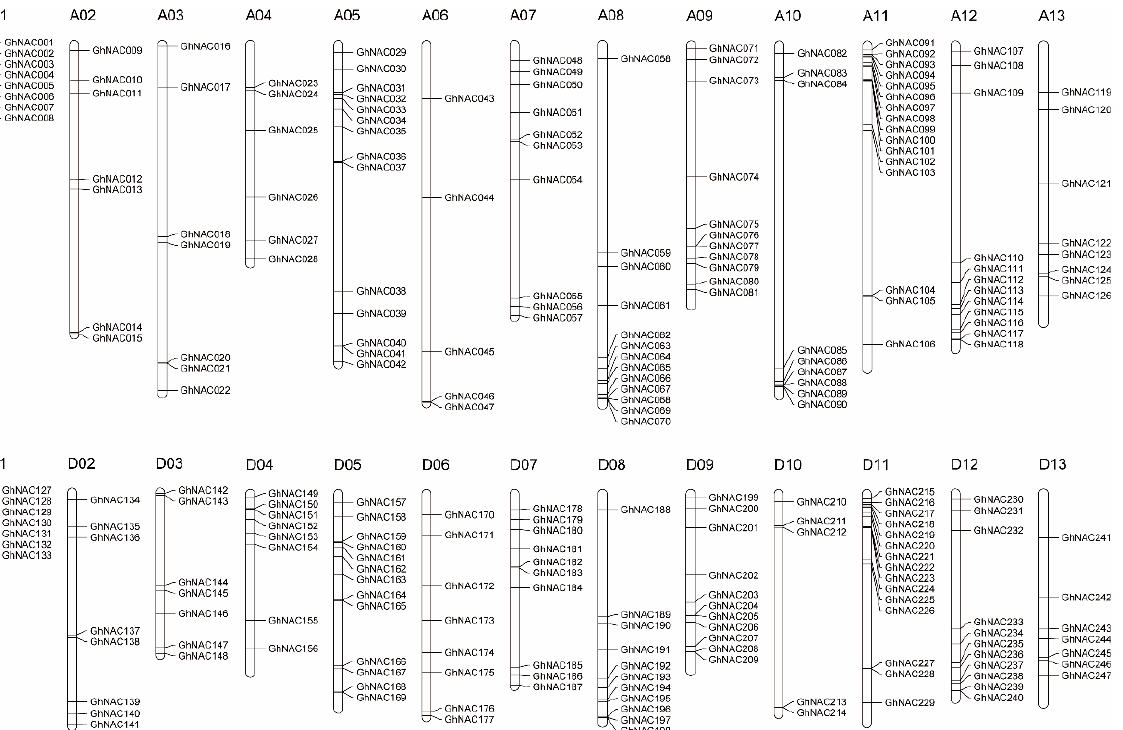
Figure 1. Phylogenetic tree of the 271 GhNAC proteins. Multiple sequence alignment of NAC do- main sequences of G. hirsutum L. and Arabidopsis was performed using Clustal X2. MEGA 7.0 was used to construct the neighbor-joining (NJ) tree with 1000 bootstrap replicates. Various colors indi- cate different groups of GhNACs.